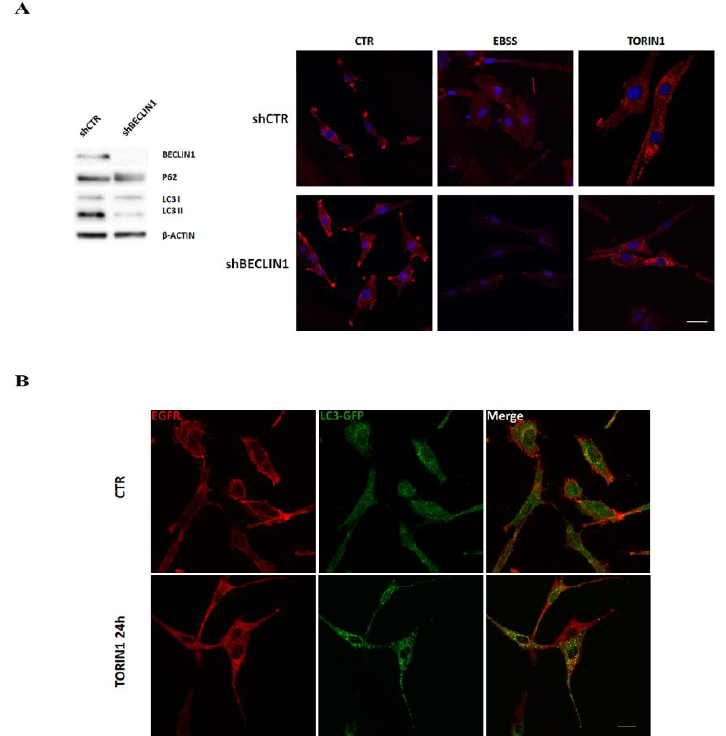
Figure 2. EGFR de-localisation in GBM cells is independent of canonical autophagy. ( A ) shCTR and shBECLIN1GL15cells[23]wereculturedinDMEM(CTR)oraminoacid-andserum-freemedium(EBSS) media or in DMEM in the presence of 250 nM Torin1 for 18 h and subjected to immunocytochemistry and confocal analysis for EGFR localisation (red) (right panels). Hoechst 33342 was used to stain nuclei (blue). Scale bar, 30 µ M. Western blot analysis of P62 and LC3 I / II was also performed in basal conditions to check autophagy status (left panel). A specific antibody for BECLIN1 was used to check the silencing e ffi ciency. β -ACTIN was used as loading control. The blot is representative of three independent experiments. ( B ) U87MG cells were transduced with GFP-LC3-expressing retrovirus as described in Material and Methods. Infected cells, cultured in DMEM alone (CTR) or in DMEM containing 250 nM Torin1 for 24 h, were subjected to immunocytochemistry and confocal analysis for EGFR (red) and autophagosomes (green) localisation. Colocalisation was excluded by calculating the Pearson’s correlation coe ffi cient r (mean r CTR, 0.15 ± 0.02; Torin1, 0.2 ± 0.03). The images showing the merge of the two signals are shown in the right panels. Scale bar, 30 µ